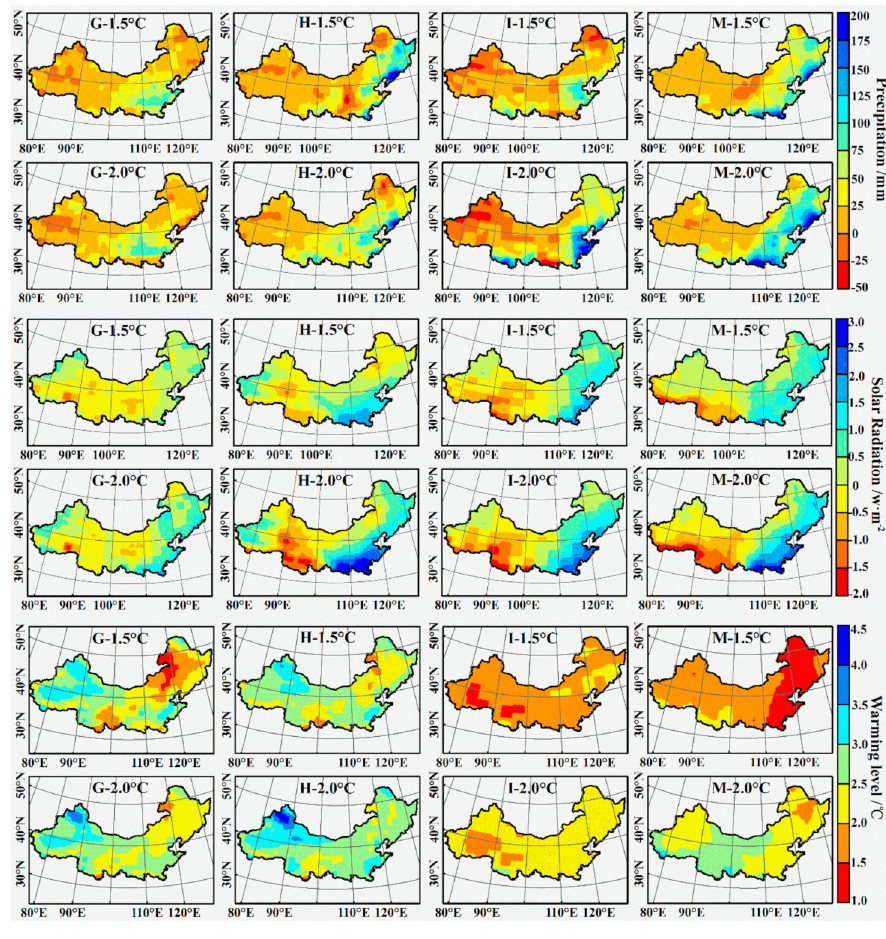
Figure 7. Spatial variation of precipitation, solar radiation and warming level in SAONC. Each letter represents a di ff erent climate model; G represents the GFDL-ESM2M model, H represents the HadGEM2-ES model, I represents the IPSL-CM5A-LR model, and M represents the MIROC5 model.